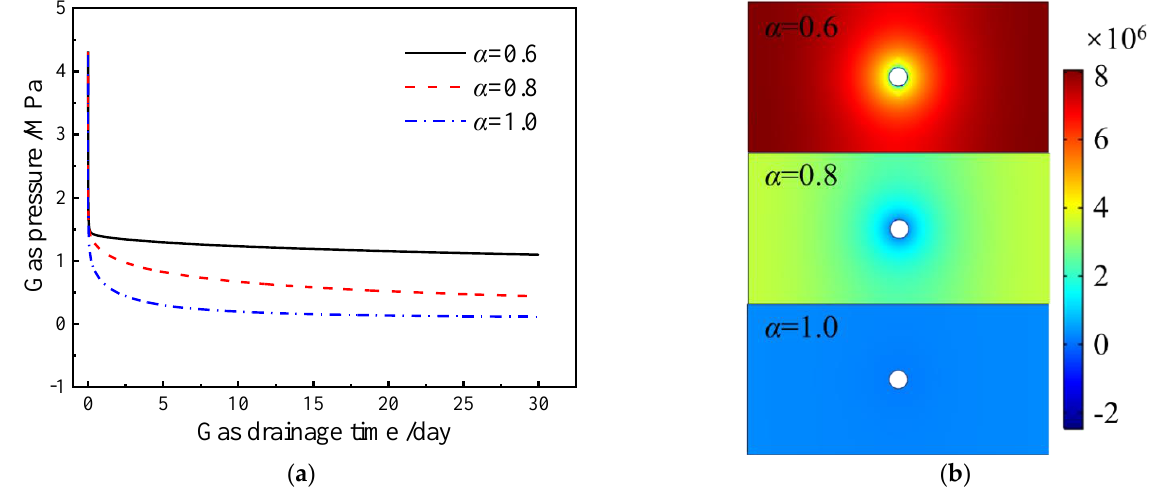
Figure 7. The effect of fractional derivative order on gas pressure. ( a ) The effect of fractional derivative on gas pressure with drainage time and ( b ) Distribution cloud diagram of gas pressure at different fractional orders when Time = 30